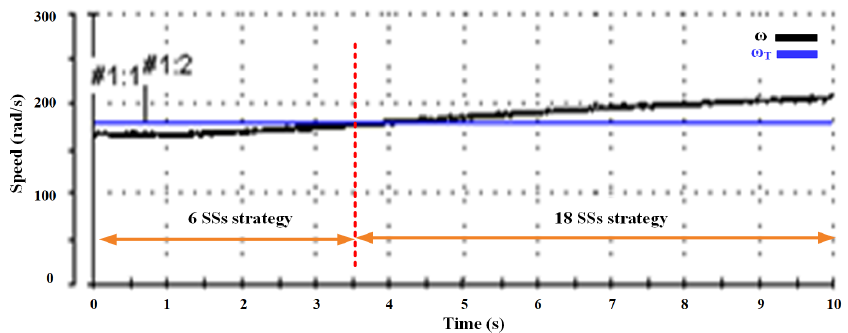
Figure 33. The DTRFC speed response with conventional 6 sectors and the proposed 18 SSs.